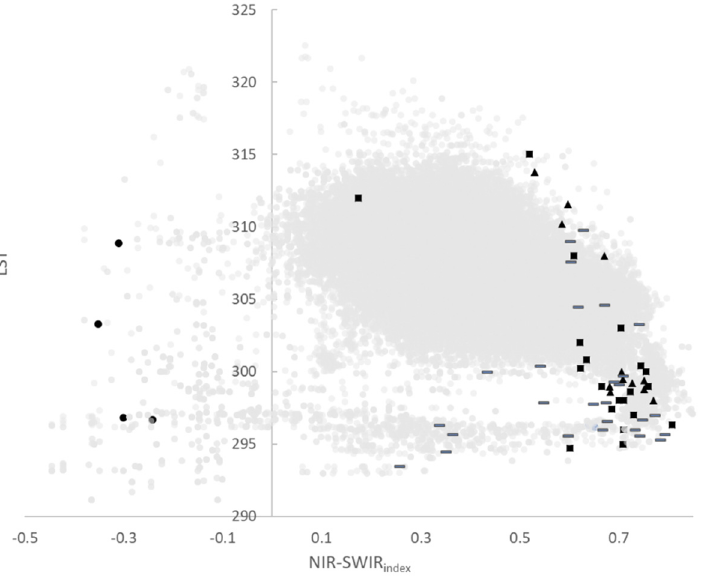
Figure 7. LST (K)/NIR-SWIR index scatterplot of field measurements taken during three campaigns of different water availability for crops use (triangles: corn; rectangles: soybean; lines: barley; circles: bare soil). Daily remotely sensed data from MODIS/Aqua of the study area for days with different hydric conditions are included (light grey color).